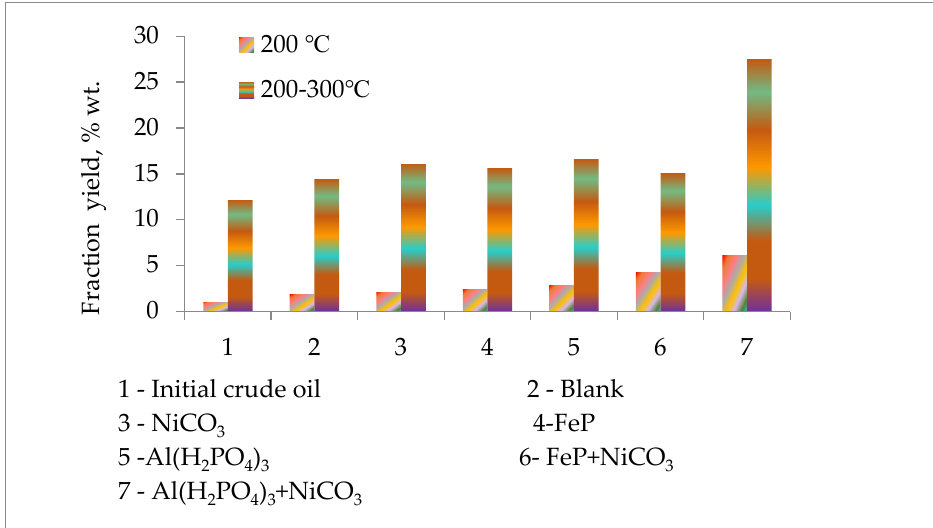
Figure 3. Light distillate yields before and after thermolysis.